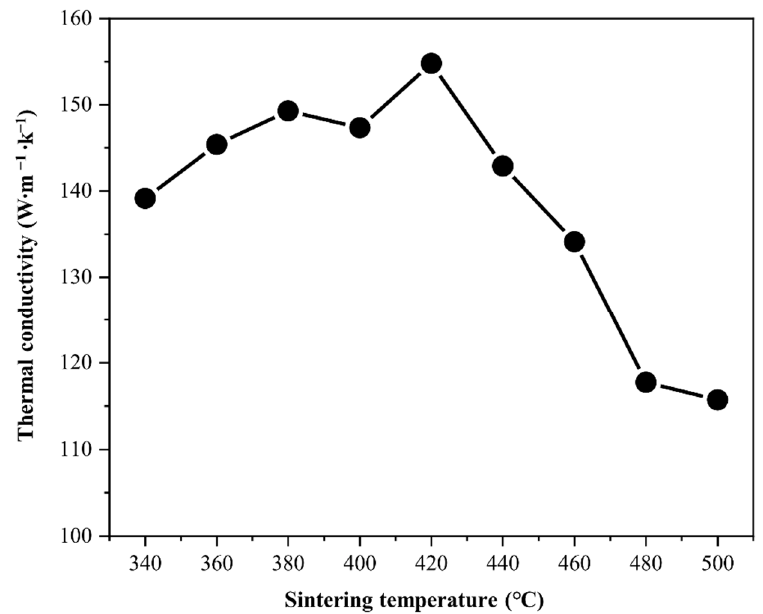
Figure 7. Thermal conductivity as a function of sintering temperature of the Al ‐ 50vol.%Cu compo ‐ sites sintered at 340, 360, 380, 400, 420, 440, 460, 480, and 500